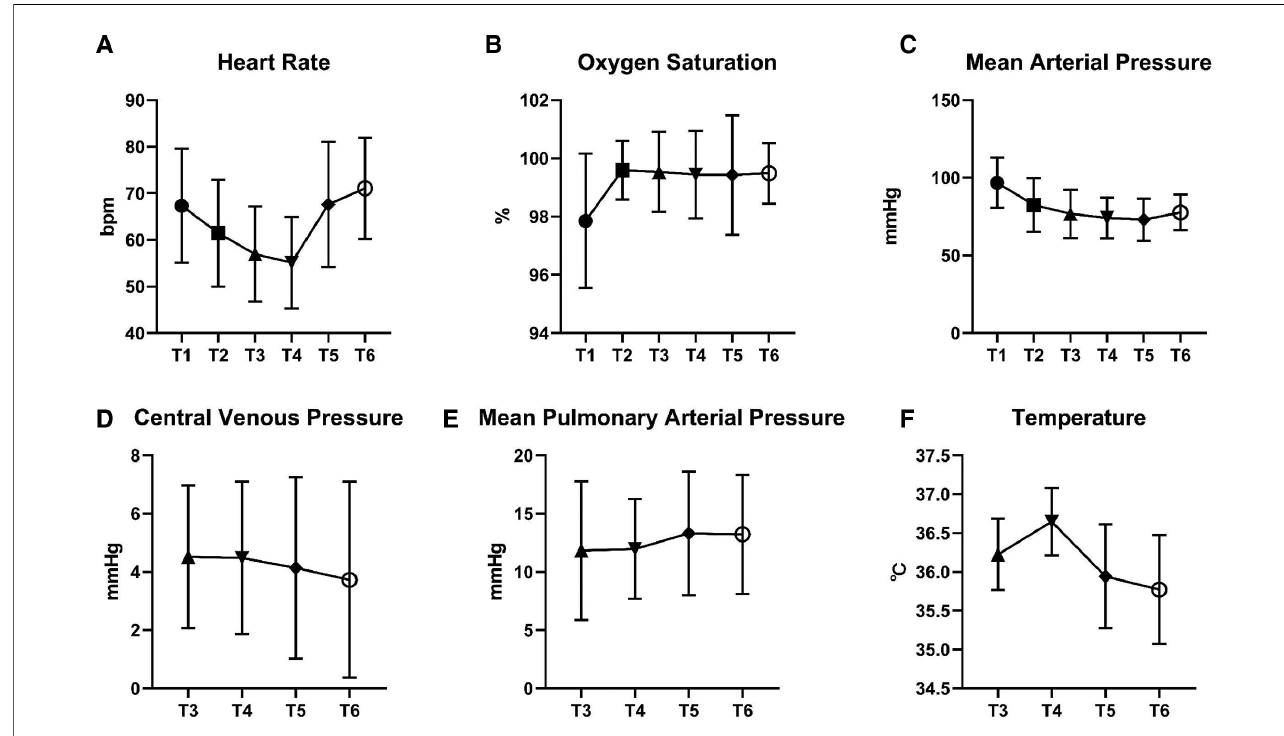
FIGURE 9 Vital signs during the surgery. The hemodynamic fl uctuation, oxygenation, and core temperature during the surgery are displayed in this fi gure. T1=Before induction ( ● ); T2=After endotracheal intubation ( ▪ ); T3=Skin incision ( ▴ ); T4=Protamine administration ( ▾ ); T5=During sternum closure ( ◆ ); T6=End of operation ( ○